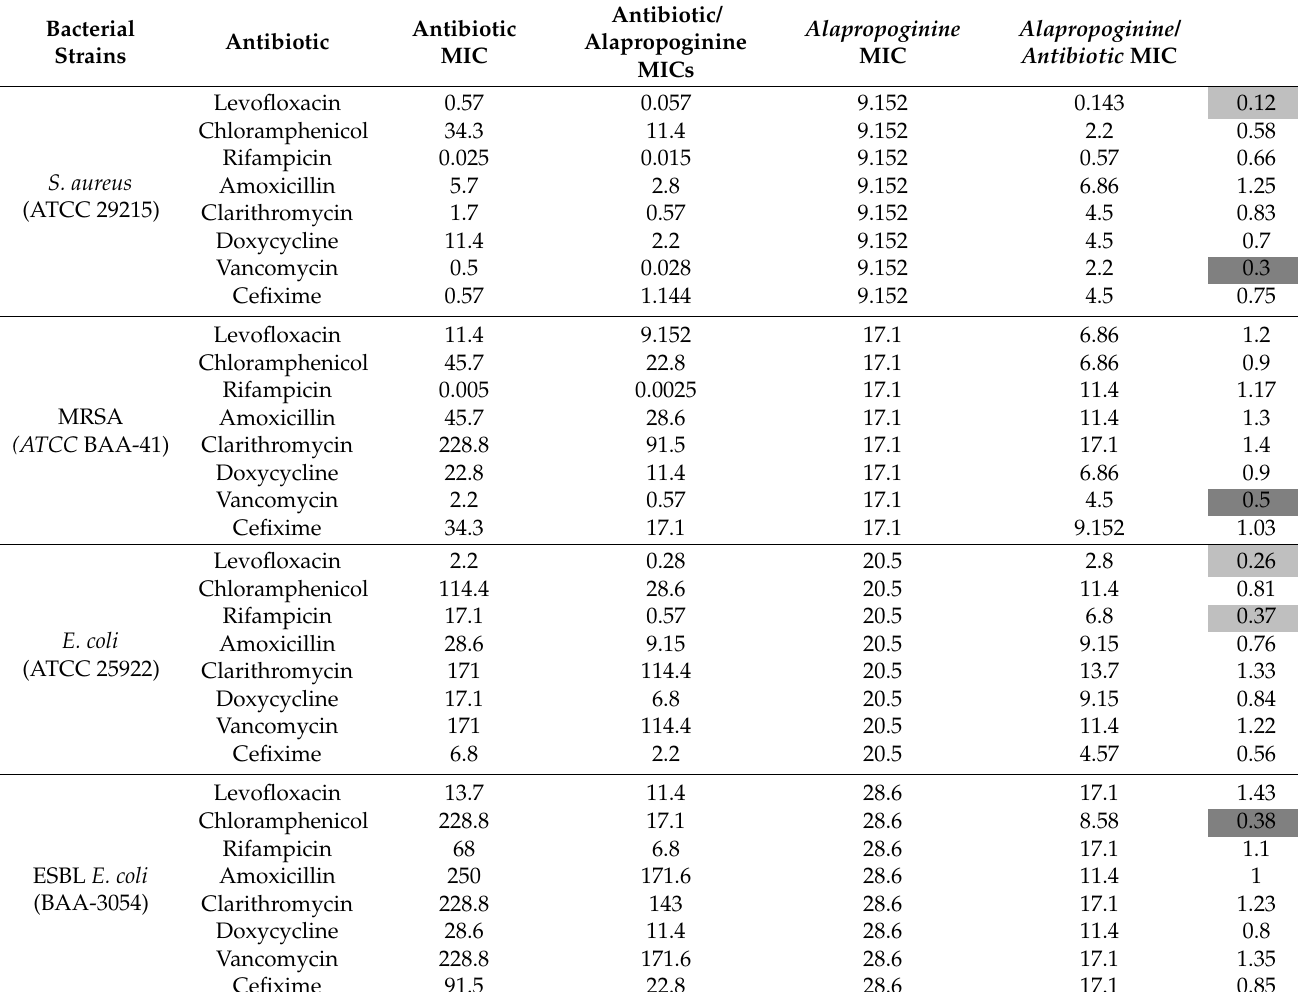
Table 4. Combinatorial antimicrobial activity of alapropoginine and antibiotics including the fractional inhibitory concen- trations (FIC) indices for the antimicrobial combinations against tested bacterial species. MICs are expressed in µ g/mL. Bacterial Strains